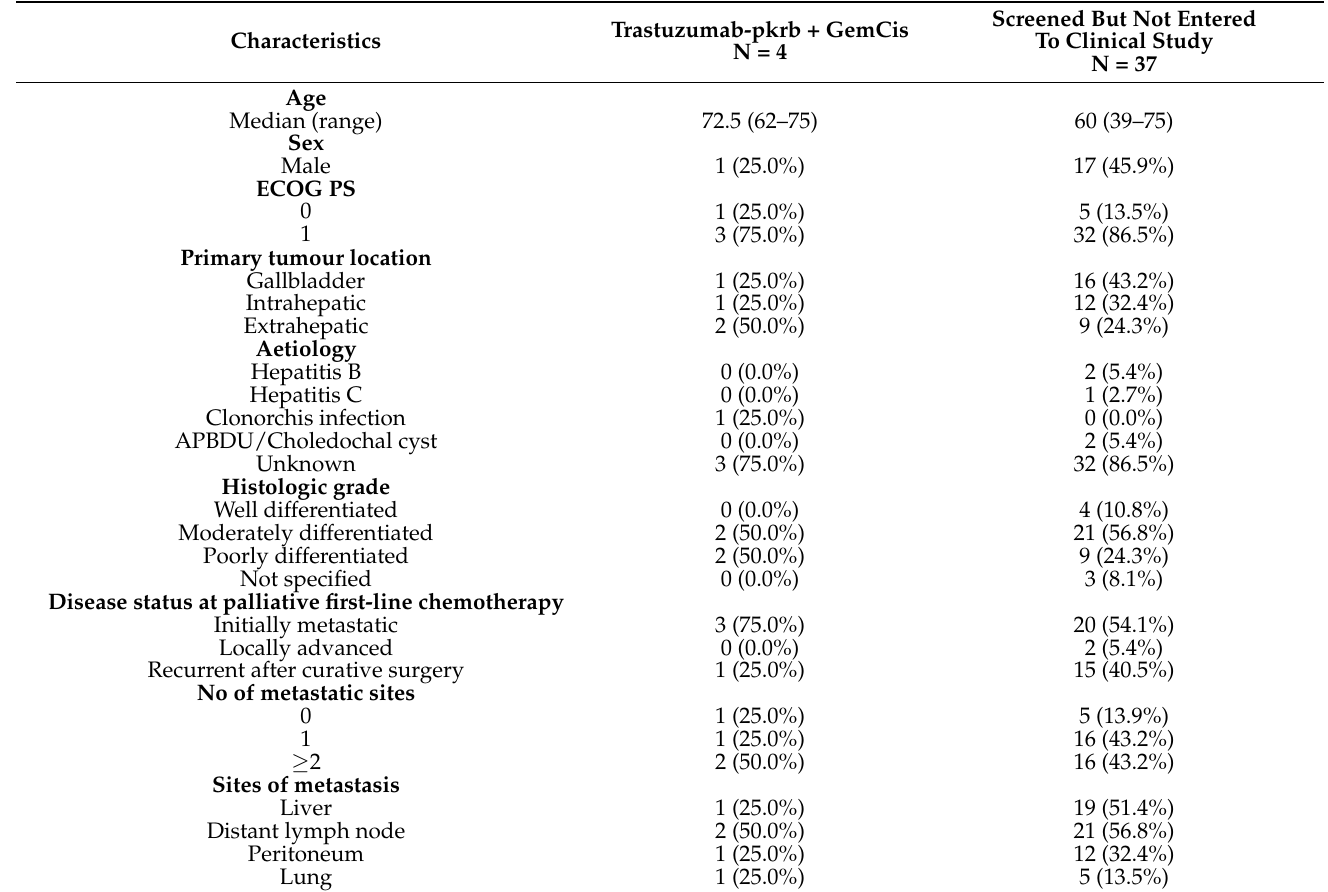
Table 1. Baseline characteristics.